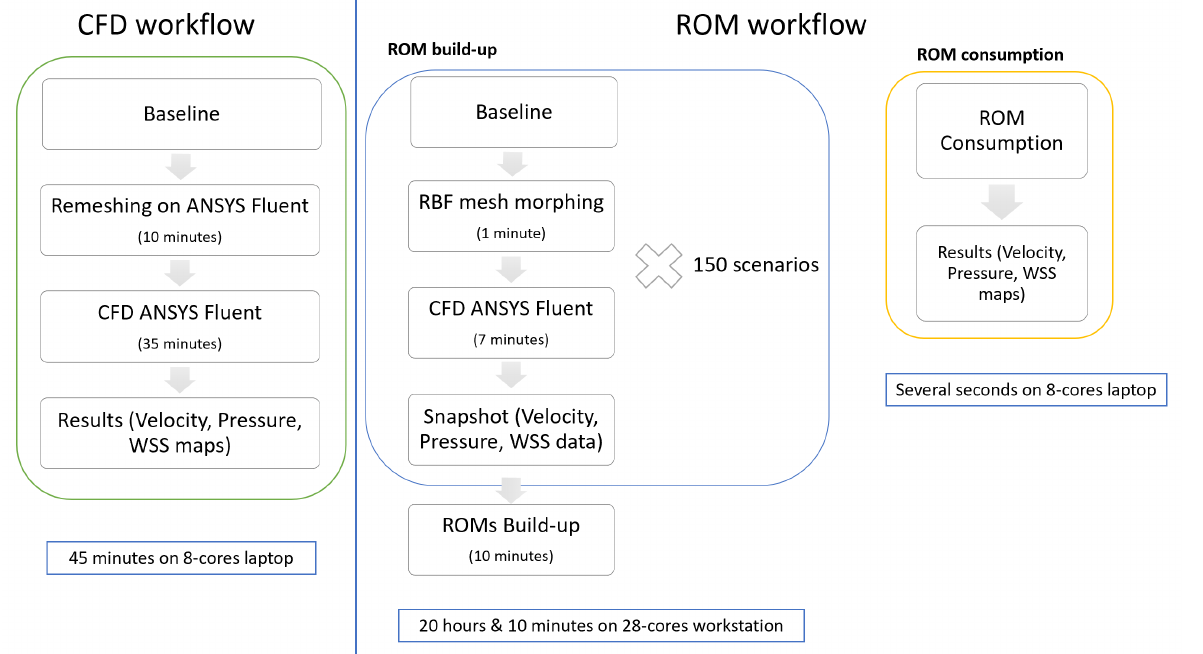
Figure 11. Timeframe comparison between the CFD and the ROM for exploration of possible MBTS